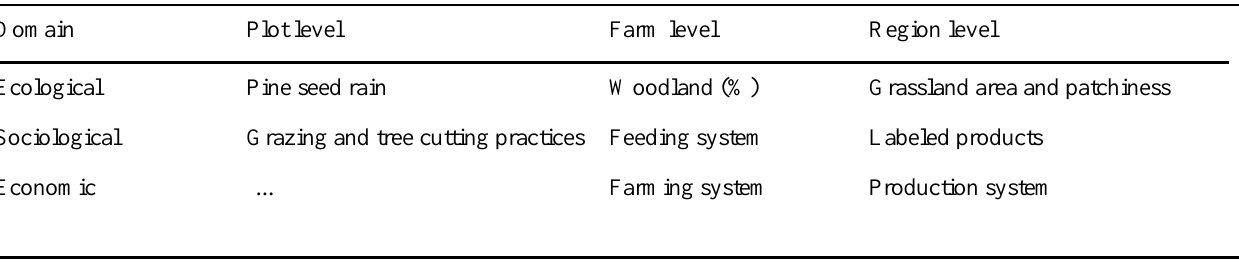
Table 1 . Thresholds operating in the Causse Méjan